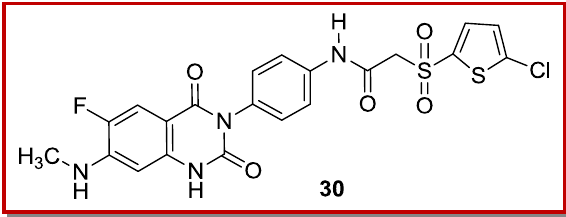
Figure 16: Elinogrel as selected quinazoline-based antithrombot- ic marketed drug